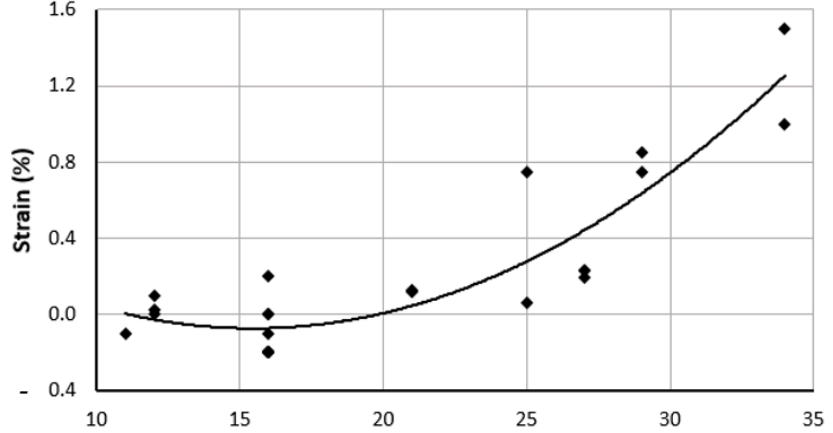
Figure 2. Overall strain trend of embryonic chick ventricles (LV and RV) presented as a percentage, as compiled from multiple literature sources, from HH11 to HH34. Corresponding references are cited in the text and in Table 2. HH: Hamburger-Hamilton stages.